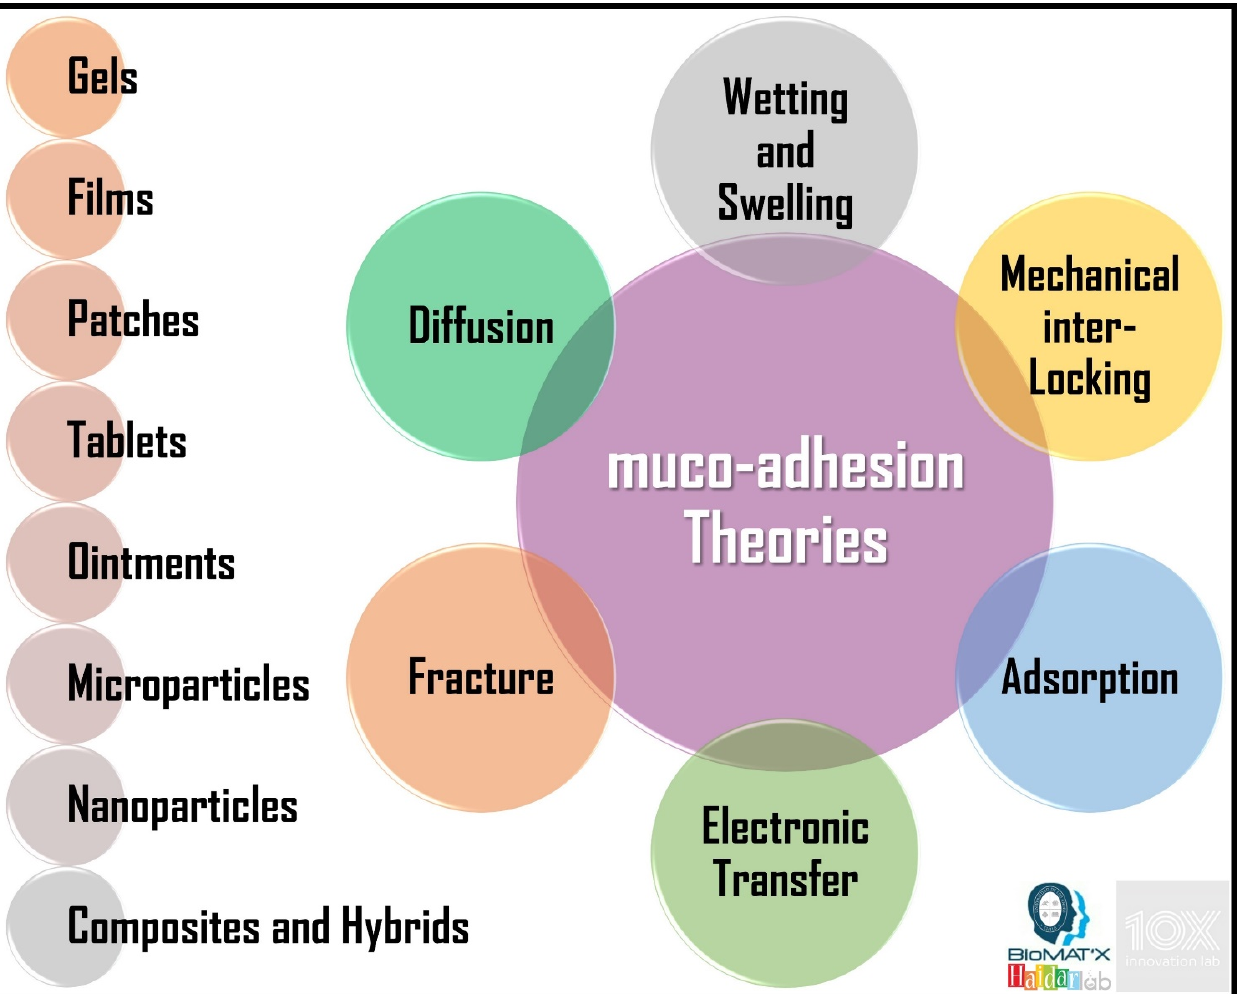
Figure 1. Theories of muco-adhesion and possible types or formats of muco-adhesive formats.